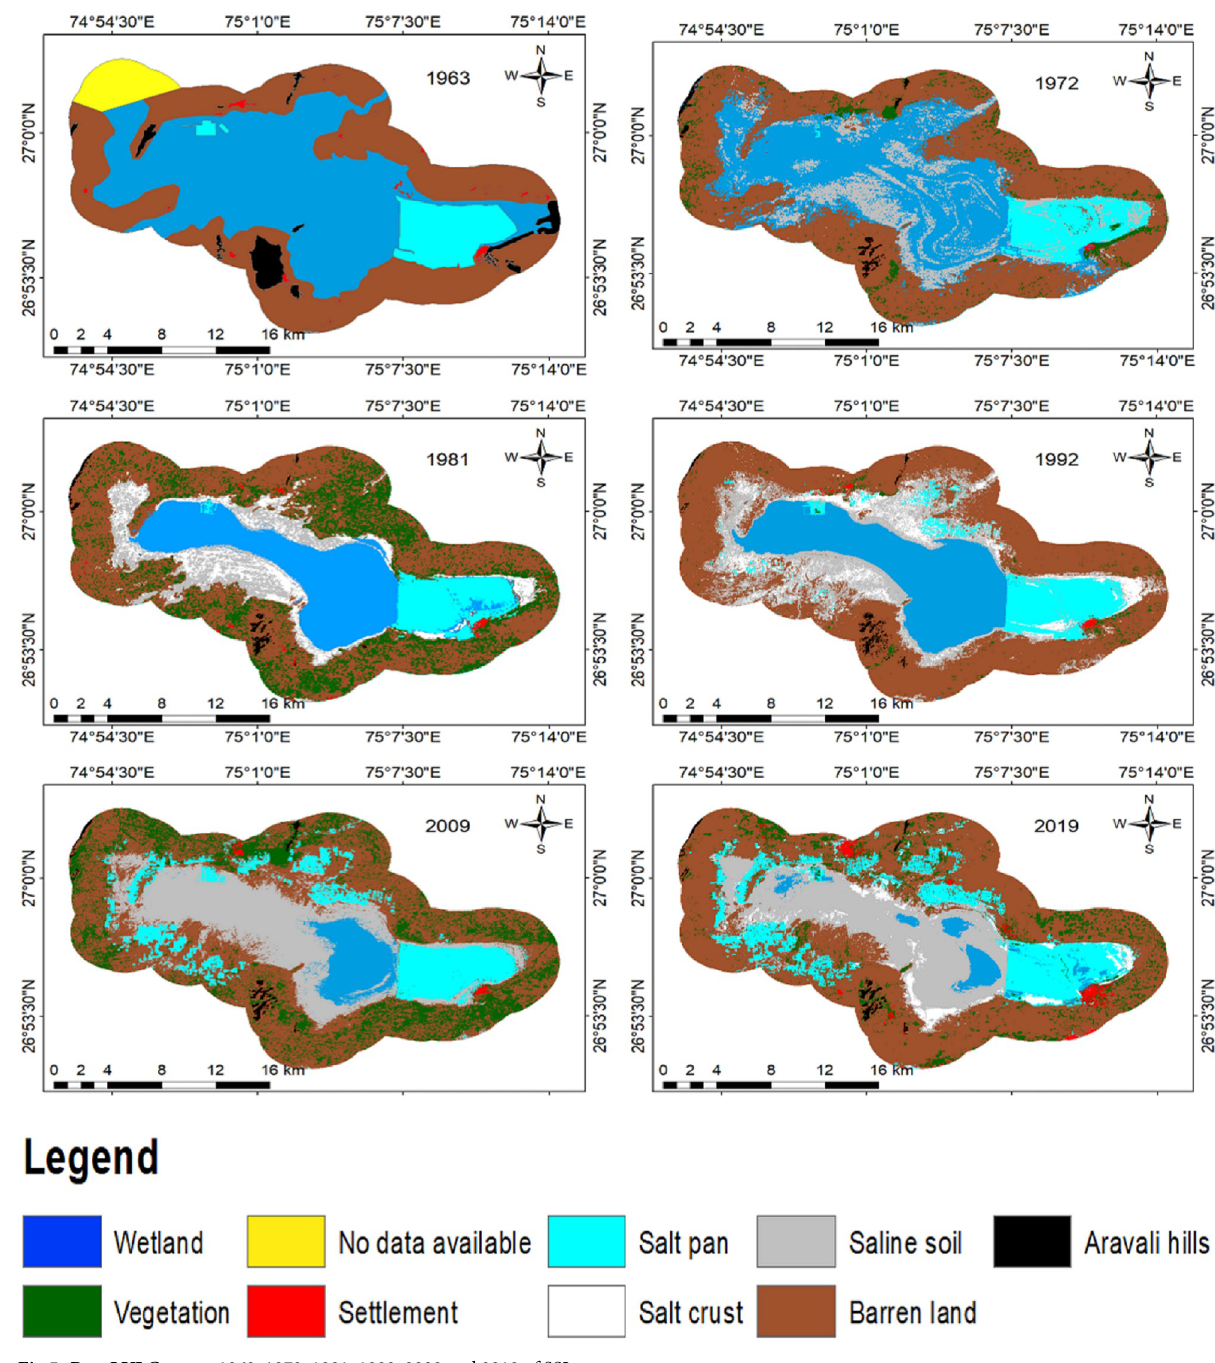
Fig 5. Past LULC maps. 1963, 1972, 1981, 1992, 2009 and 2019 of SSL. LULC change rate (Table 3) is represented as K (%). It shows the wetland degrading at the rate of -4.23%, 0.73%, -4.14%, and -4.47% since 1972–2019. In fact, in the first decade, K of vegetation was 43.38% and settlement was 12.66%. Salt pan decreased by 0.63%, Aravali hills by 0.56%, saline soil by 2.62%, and barren land by 1.24%. Furthermore, from 1981 to 1992,